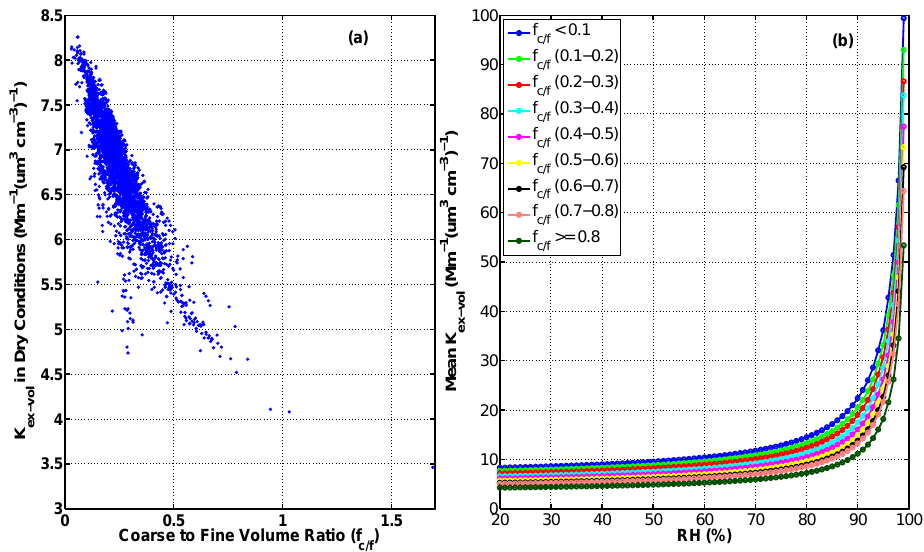
Fig. 6. Variation of the aerosol volume extinction coefficients ( K ex-vol ) with coarse to fine volume ratio ( f c/f ) in (a) dry conditions and (b) varying RH conditions, respectively. Colored lines in (b) stand for the corresponding coarse to fine volume ratio ranges as the legend